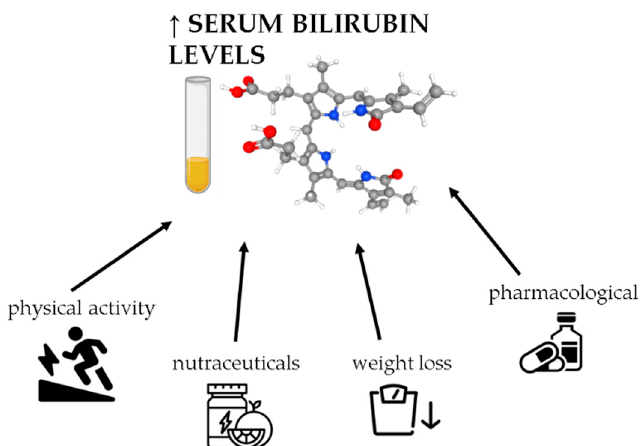
Figure 2. Approaches to modulate serum bilirubin levels in obesity. Bilirubin can be upregulated by different types of interventions, including exercise, diet, pharmacological, and nutraceutical interventions.